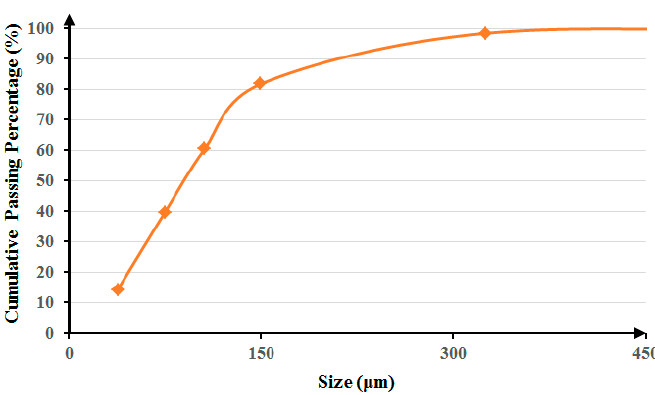
Figure 1. Copper smelter flue dust size distribution.